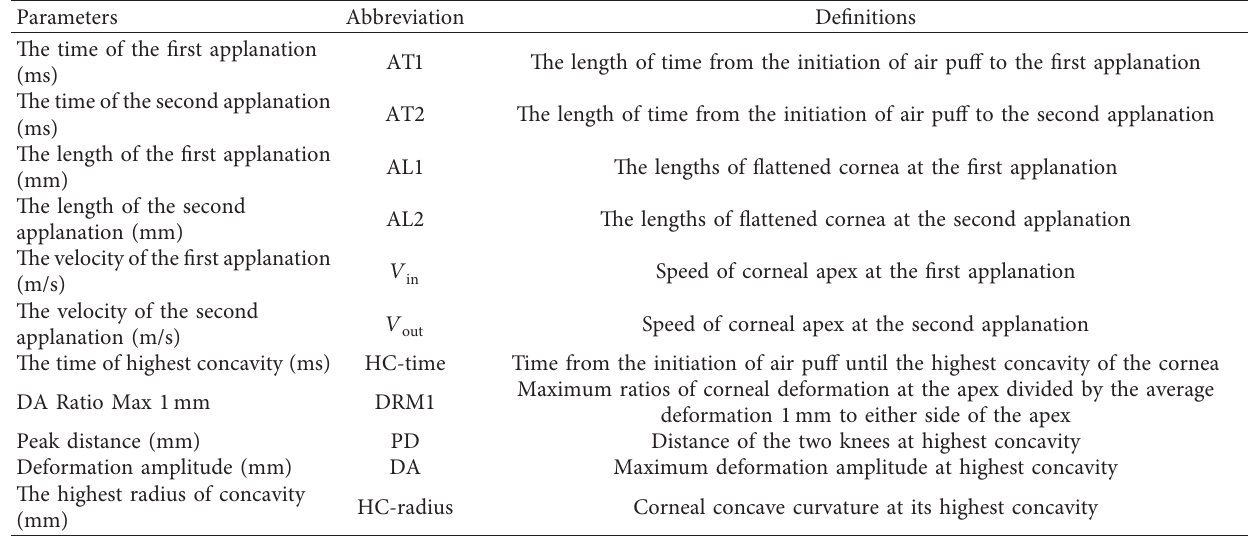
Table 1: Biomechanical parameters derived from the Corvis ST software and their corresponding definitions.